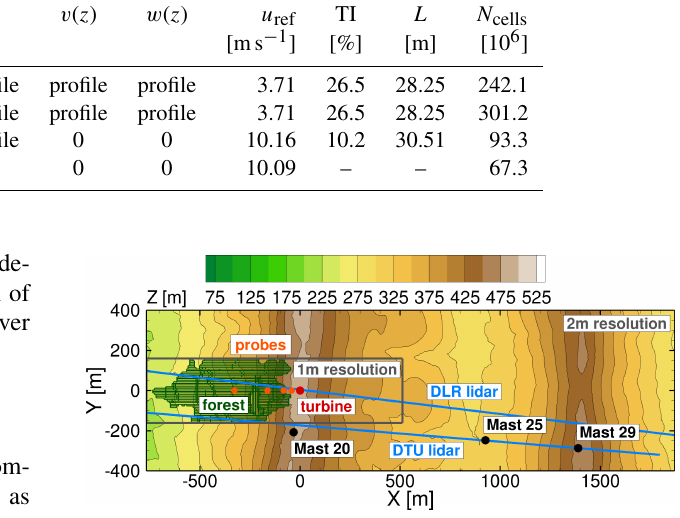
Figure 6. Location of lidar planes, met masts and probe positions in Perdigão relative to the turbine and properties of the FLOWer